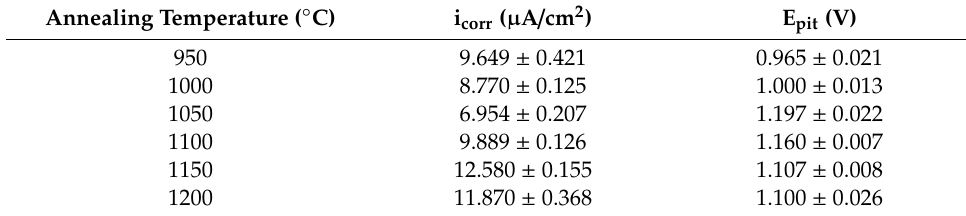
Figure 7. ( a ) Corrosion current density and ( b ) pitting potential of S32750 stainless steel at different annealing temperatures. Table 3. Corrosion current density (i corr )and pitting potential (E pit ) values (average ± standard deviation) of S32750 stainless steel at different annealing temperatures. The average and standard deviation values were obtained from 5 experiments.